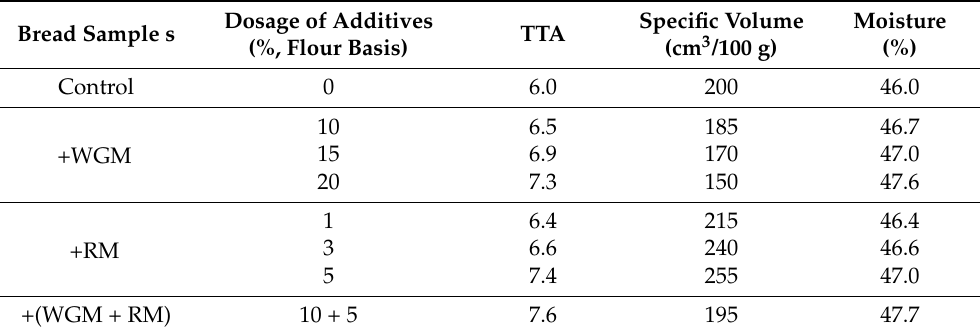
Table 1. The effect of wheat germ meal (WGM) and rosehip meal (RM) on the total titratable acidity (TTA), specific volume, and moisture content of rye–wheat bread. Dosage of Bread Sample s